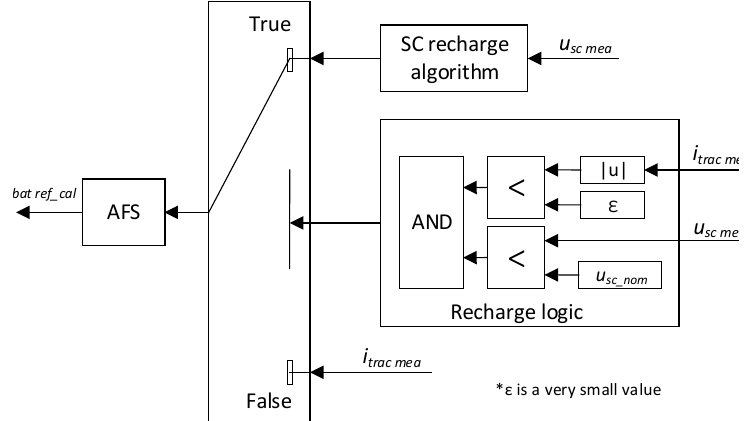
Figure 5. Supercapacitor recharge control